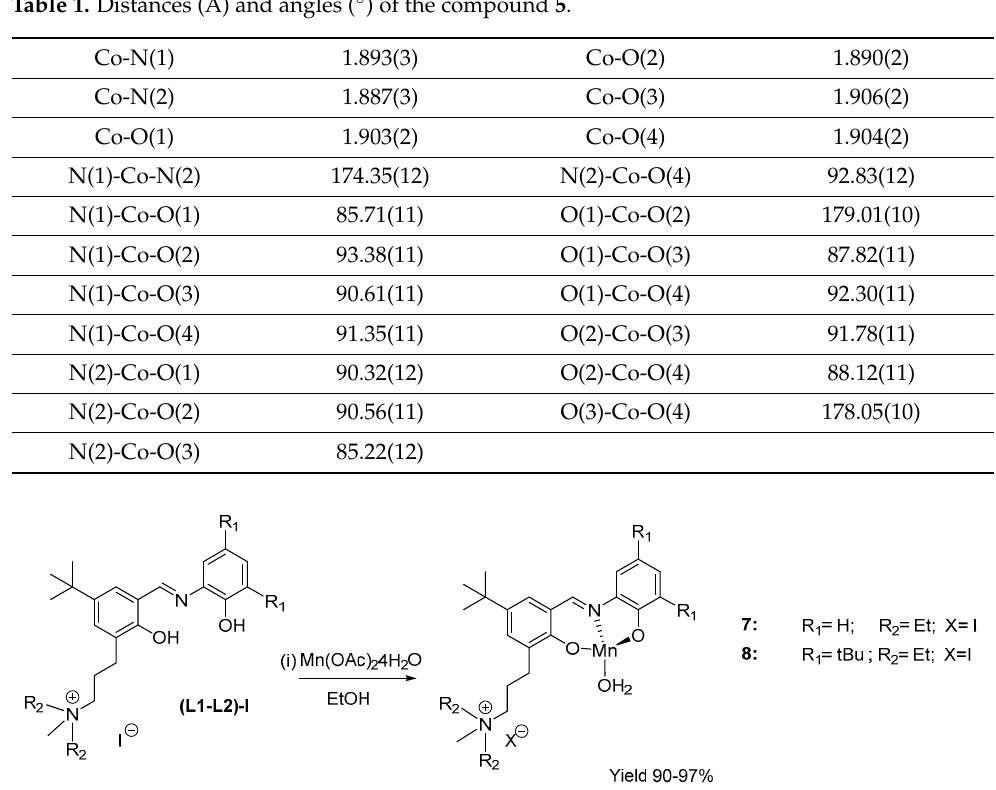
Table 1. Distances (Å) and angles ( ◦ ) of the compound 5 .